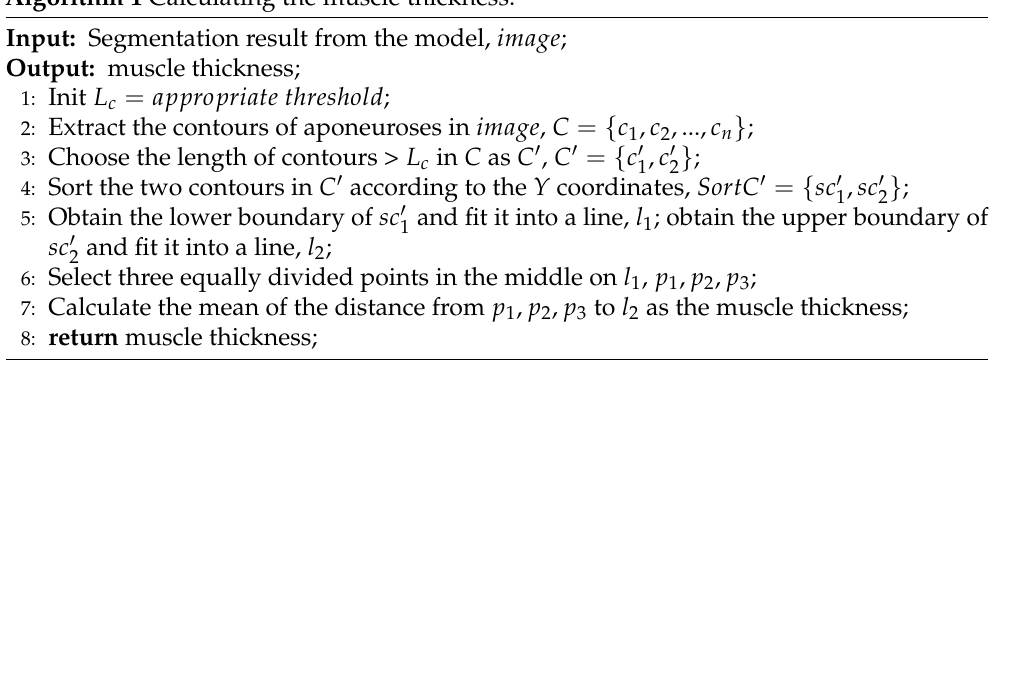
Algorithm 1 Calculating the muscle